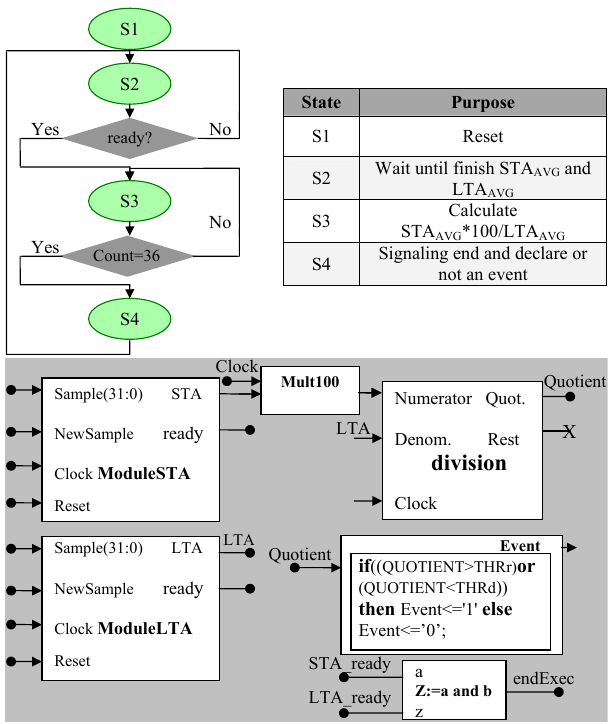
Fig. 8. (a) Data flow diagram of arithmetic average version. (b) Ta- ble of states. (c) Interconnection.